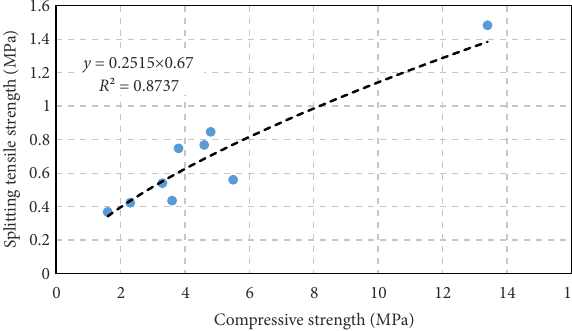
Figure 6. Relation between compressive strength and splitting tensile strength of LFC containing